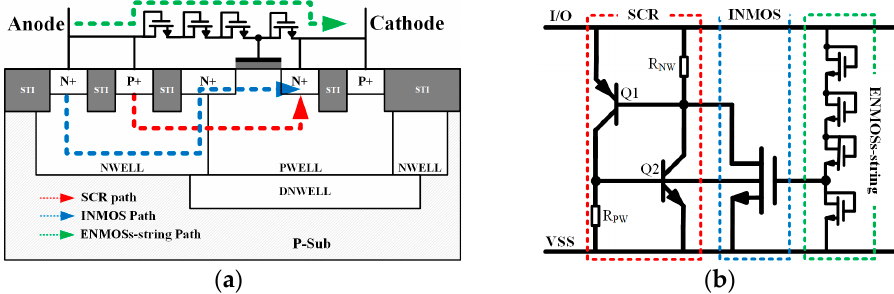
Figure 1. The proposed MTSCR device: ( a ) cross-sectional view and ( b ) equivalent